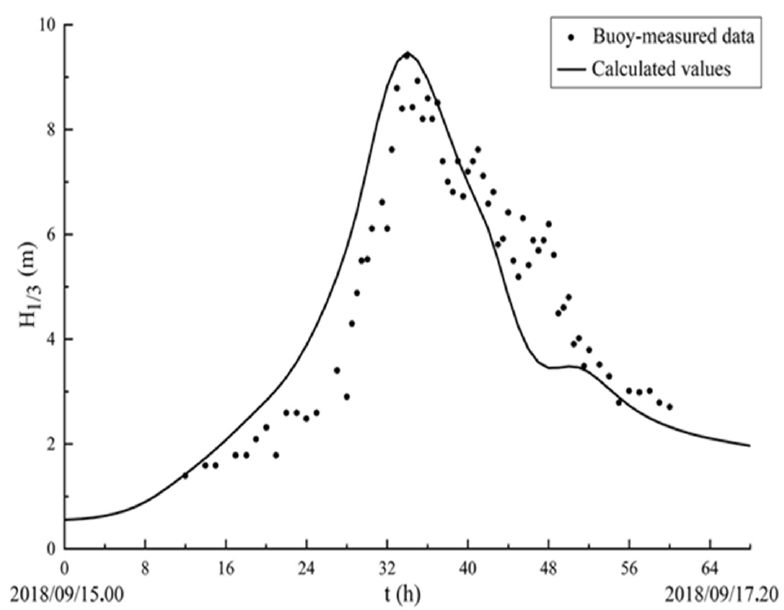
Figure 7. Comparison between the calculated values and buoy-measured data of the significant wave height.